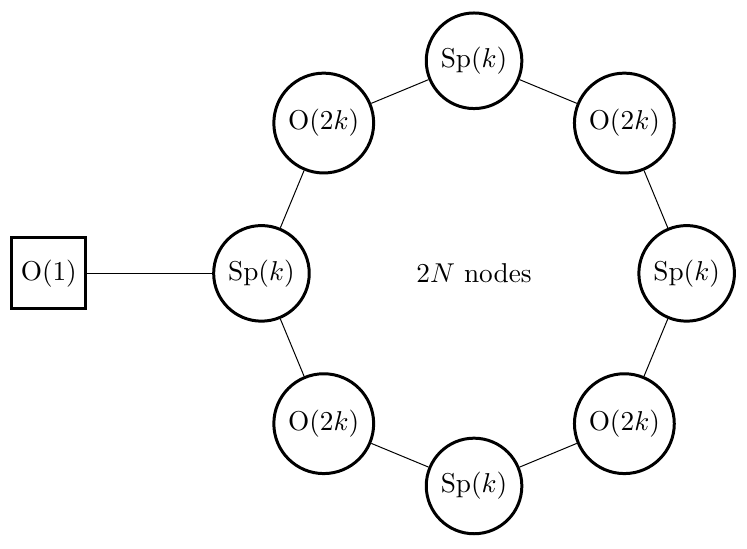
Figure 3 . Quiver de(cid:12)ning the ~ B N